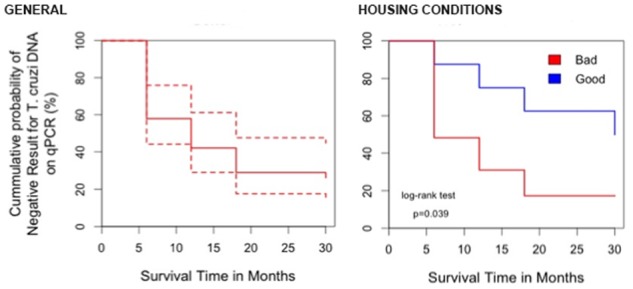
Survival analysis for positive qPCR as post-treatment end-point (time to a positive qPCR) in a) total population and b) comparing bad housing conditions (thatched roof, mood wall and dirt floor) vs good conditions (cement and tilde).